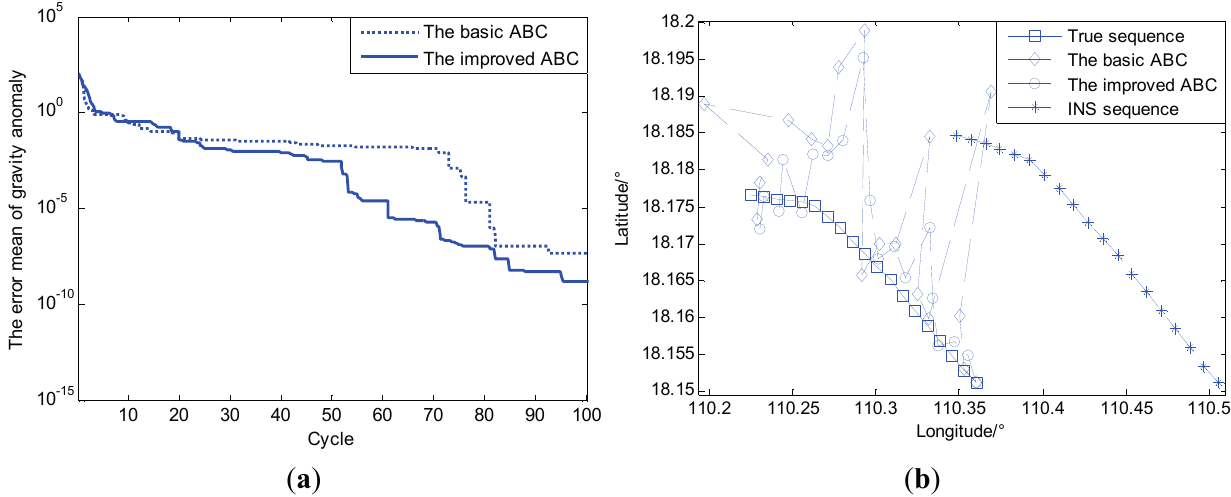
Figure 13. ( a ) Convergence curves for single point search; ( b ) Matching results for single point